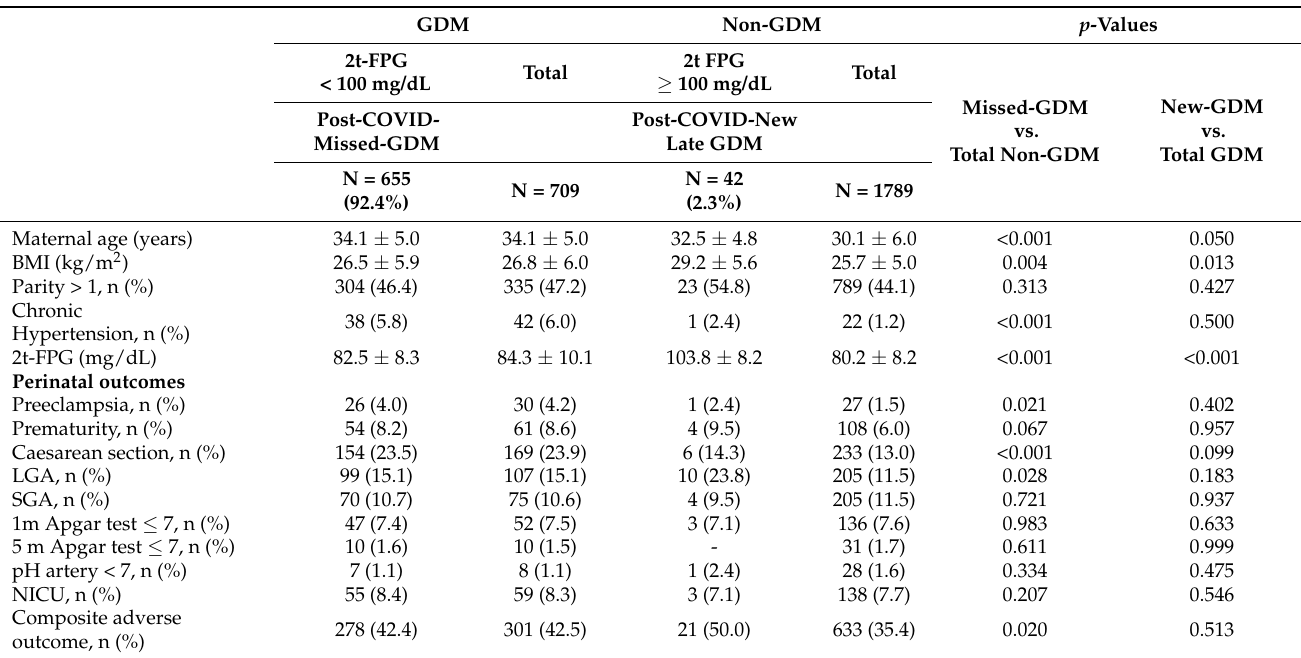
Table 5. Maternal characteristics and perinatal outcomes in pregnant women with gestational diabetes mellitus diagnosed at 24–28 weeks of pregnancy (GDM) and with normal glucose tolerance during pregnancy (Non-GDM), according to the two-step diagnosis (18) and in pregnant women with missed and new GDM based on the recommendations of the European Society of Endocrinologists (3) and the United Kingdom (5) for GDM diagnosis during the COVID-19 pandemic, second trimester fasting plasma glucose level (2t-FPG) ≥ 100